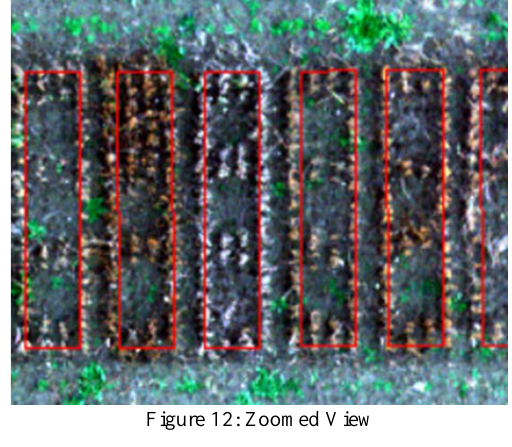
Figure 12: Zoomed